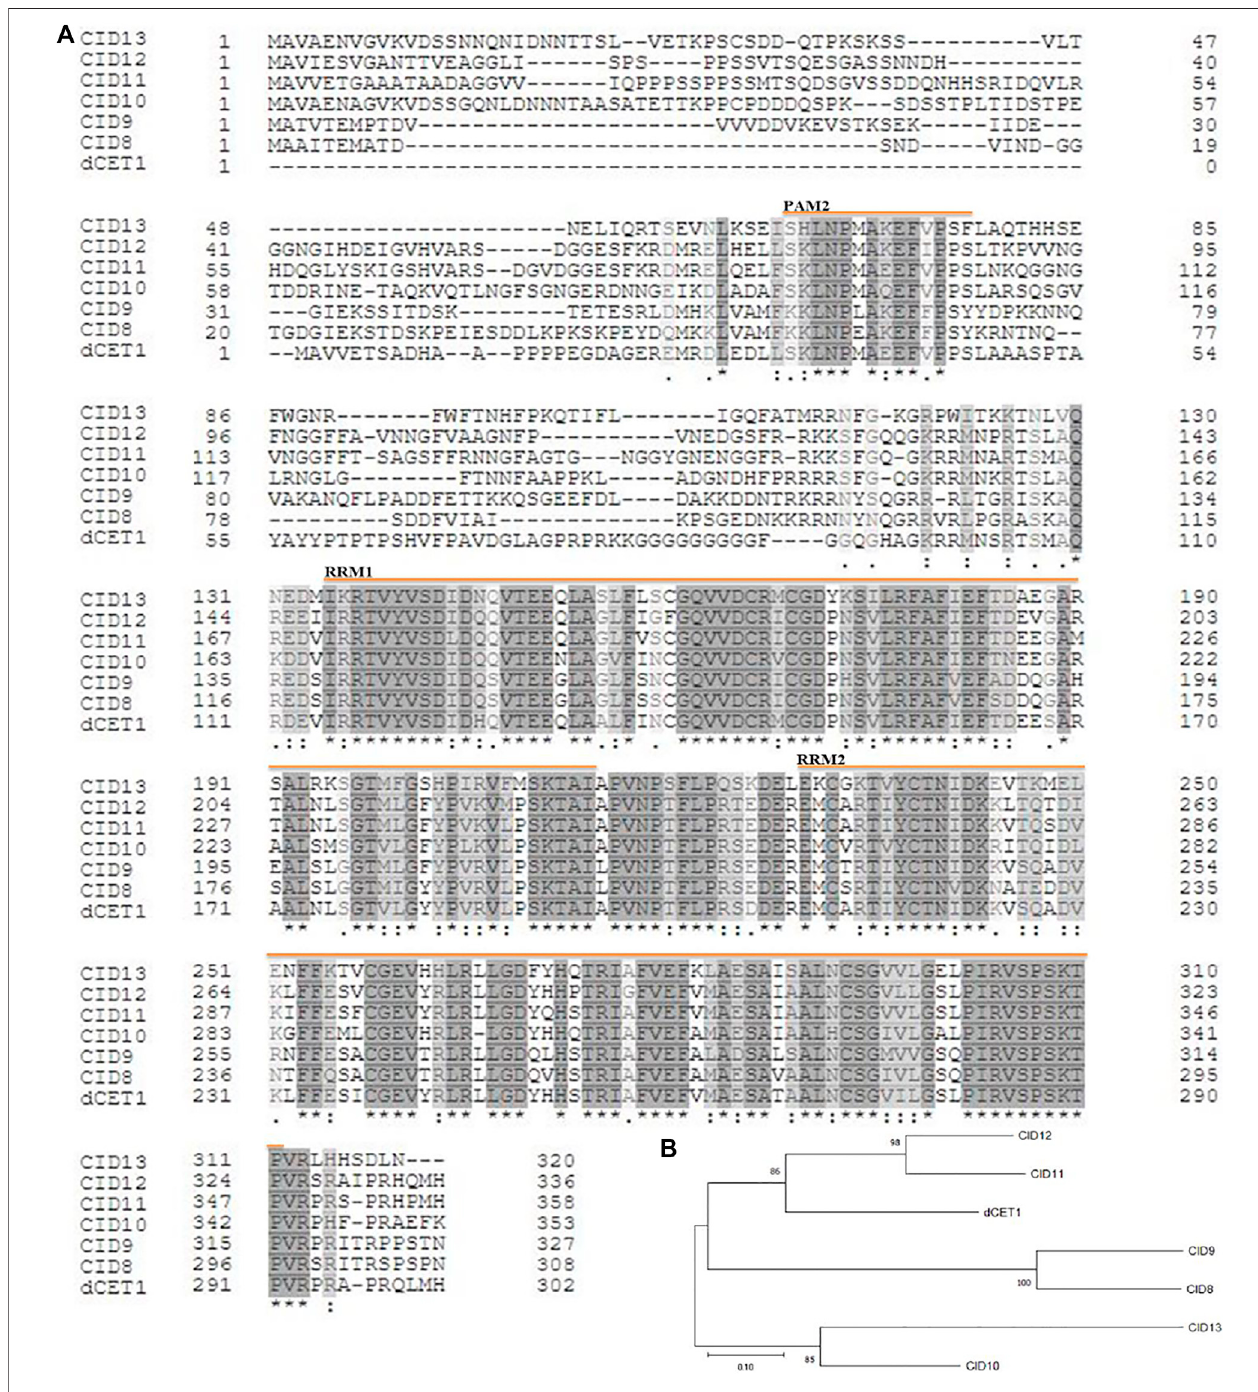
FIGURE 10 | Representation of sequence alignment and maximum likelihood tree of DCET1 and CID-D proteins. Sequence alignment of DCET1 and CID-D proteins (A) . Black and star indicate amino acid identity across all proteins; Grey and double dot indicate identity in most proteins; Light black and single dot indicate identity in many proteins; Yellow line with name indicates the region of the speci fi c domain. Phylogenetic tree of DCET1 and selected CID-D proteins (B) .